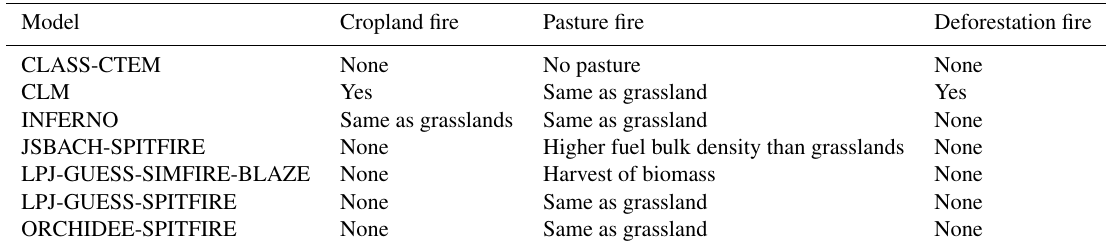
Table 5. Treatment of agricultural fires (Rabin et al., 2017b). “None” indicates the vegetation type does not burn or that deforestation fires are not represented in the model. The models treating pasture fire the same as grassland do not treat pasture as a specific PFT. The indication “no pasture” means that there is no land-cover change due to